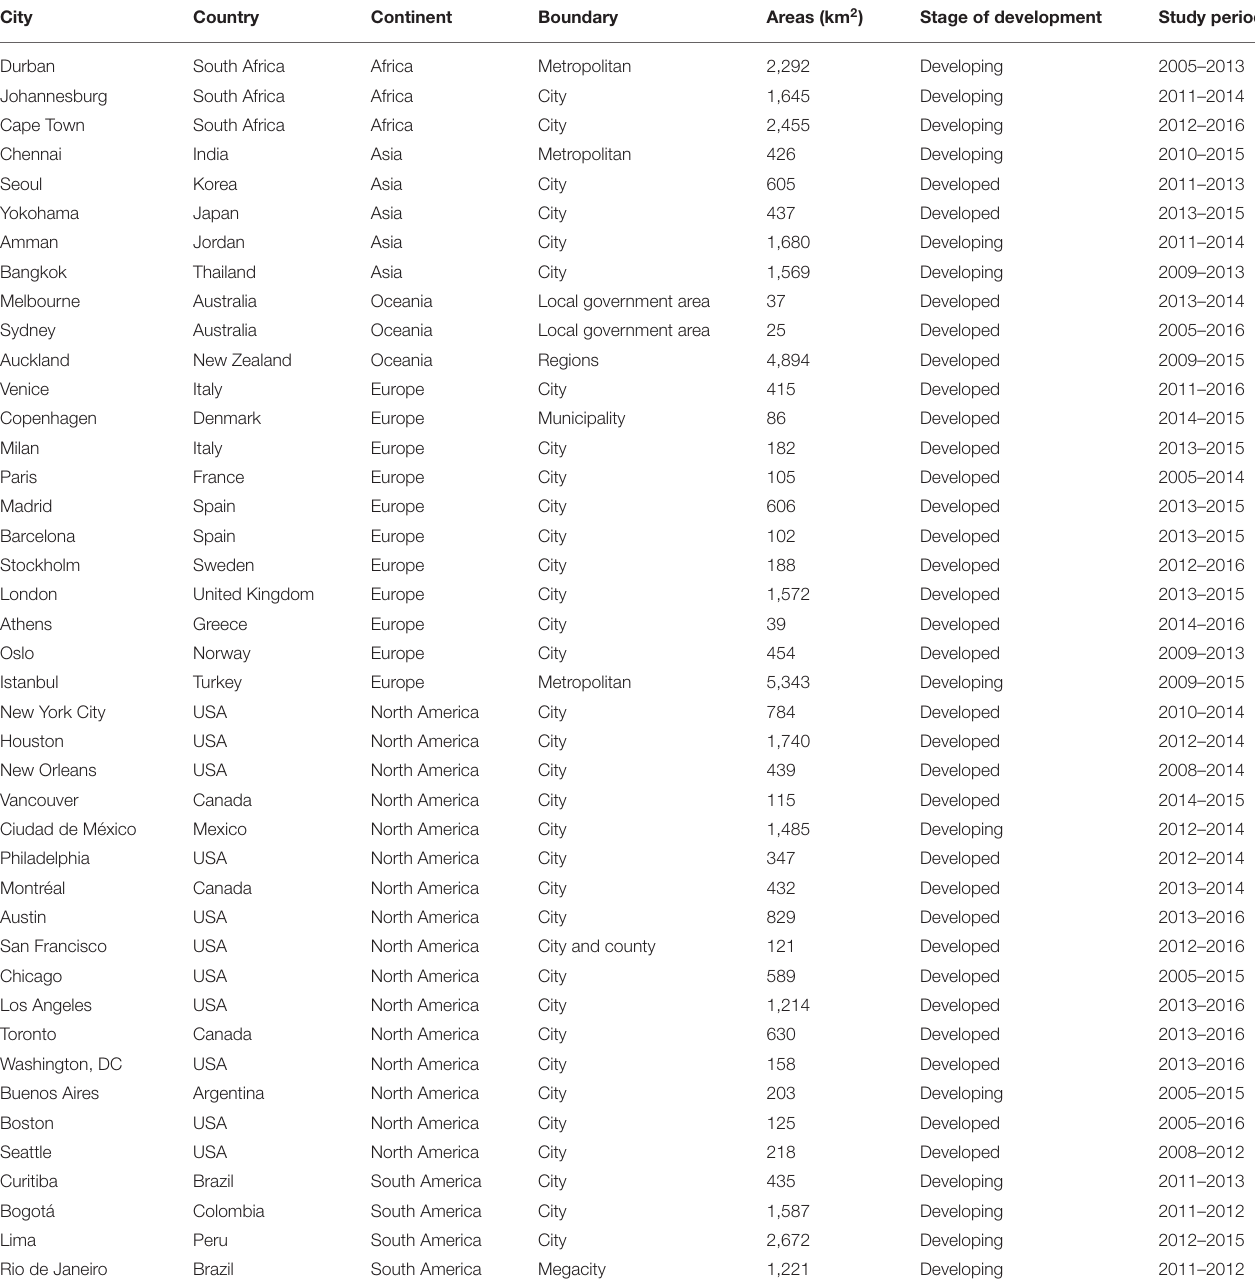
TABLE A1 | Basic characteristics and study periods of the 42 cities in the historical variations of emissions analysis (in section Historical Emission